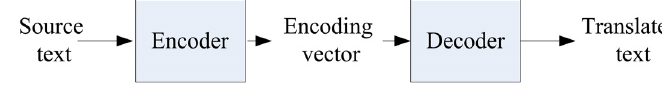
Figure 1: Basic framework of the intelligent machine translation algorithm.